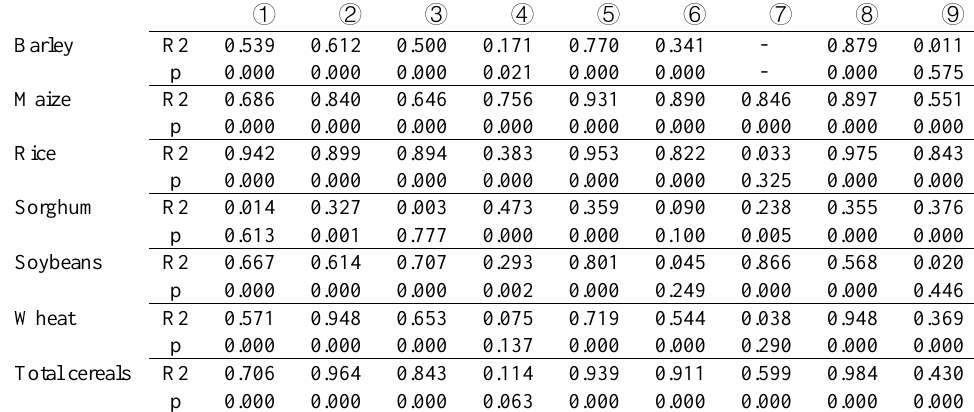
Table S2. The statistic report of the seven crops’ yield change trend in nine major crop zones from 1982 to 2012. Note that the Central Eur_Res zone is analyzed during 1992-2012 owing to the FAO’s data availability.